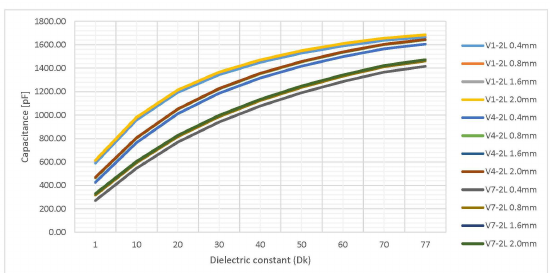
Figure 14. Simulation results of capacitance variation for 3 two-layered structures where the thickness is varied from 0.4 mm to 2 mm. The (cid:101) r of the environment is swept from 1 to 77. Data from Table 2 is